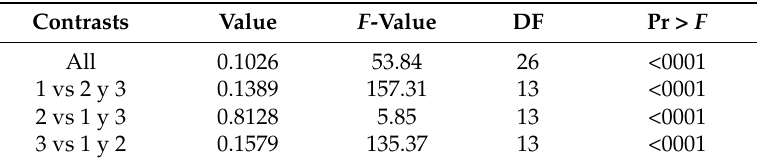
Table 4. MANOVA test criteria and approximations of F